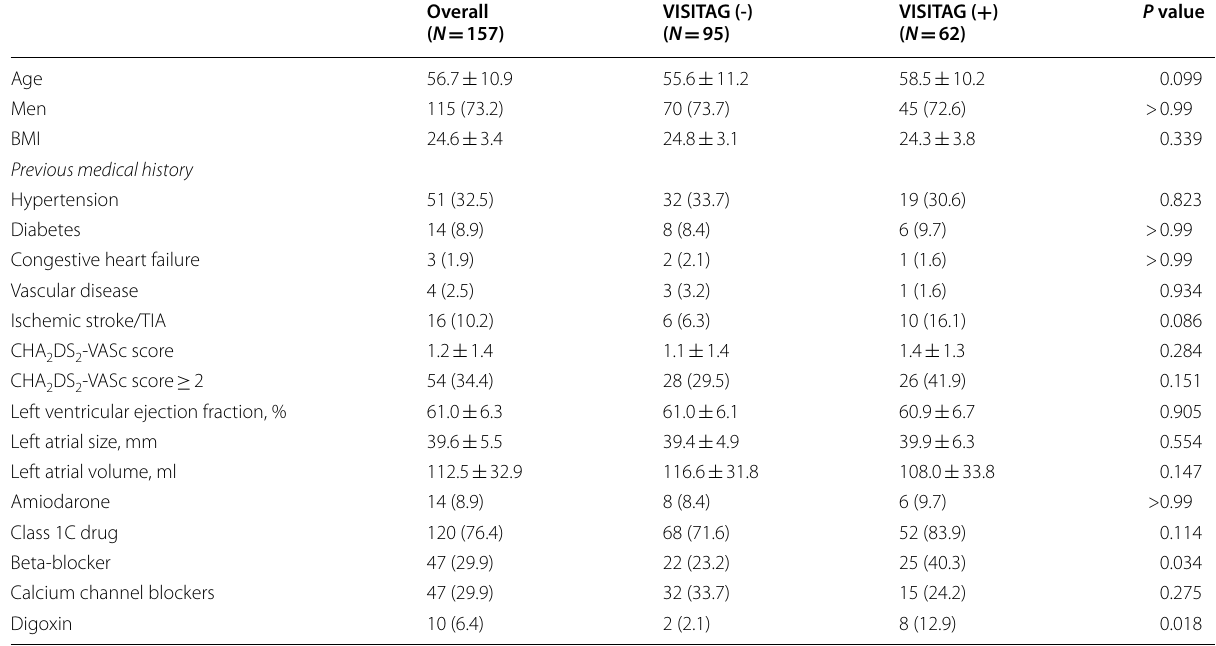
BMI body mass index; TIA transient ischemic